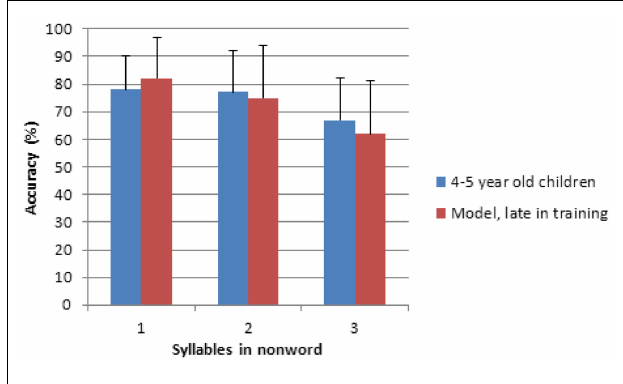
FIGURE 3 | Four- to five-year-old children’s non-word repetition performance together with the model’s performance late in its training. Error bars indicate standard deviation.